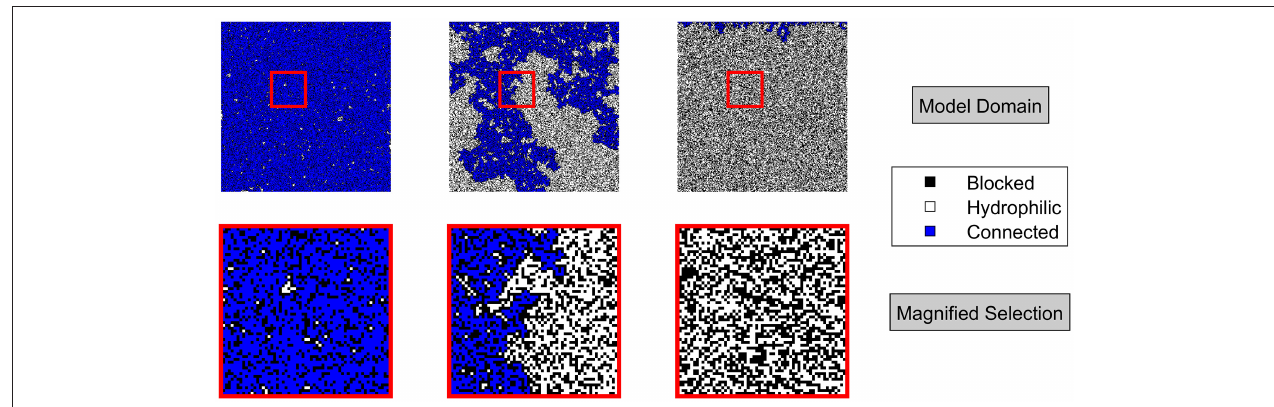
FIGURE 1 | (Top) Results from a percolation model in a 2D square lattice of 300 x 300 sites. Probability of a pore to be hydrophobic, hence blocked from left to right: 0.3, 0.41, 0.5. (Bottom) Magnification of indicated area (red rectangle) of 60 x 60 pores of above shown realizations. Hydrophobic pores are black. Hydrophilic pores are white. Open pores connected to the top of the system are